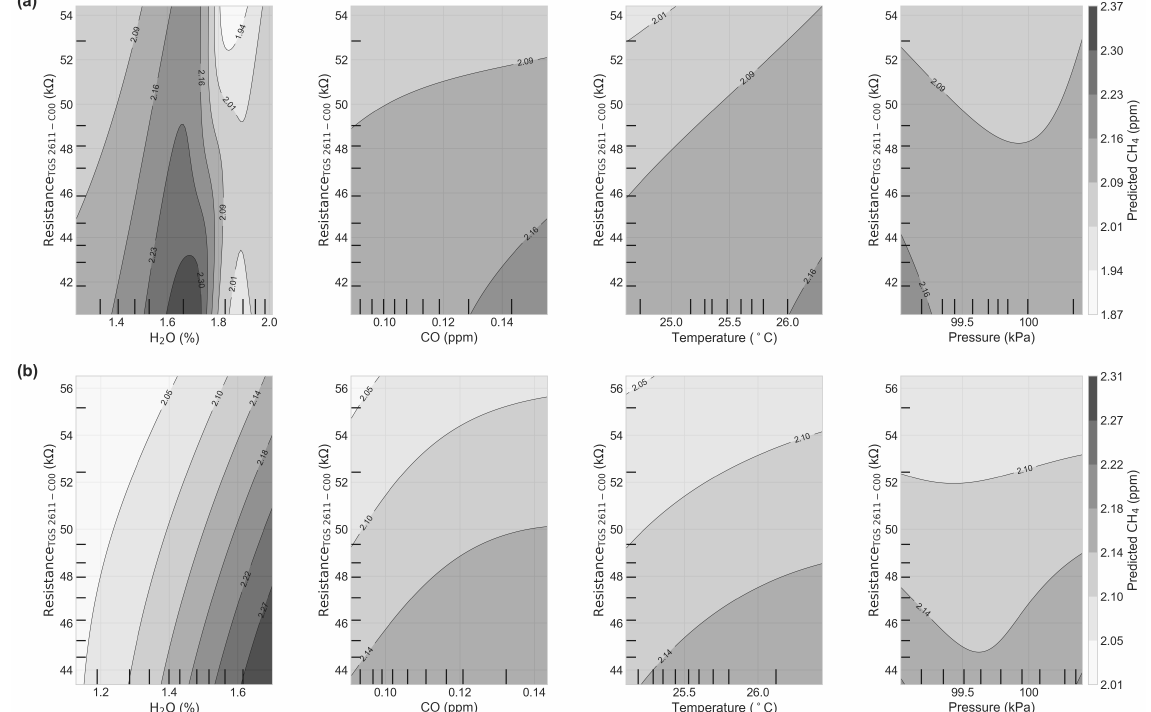
Figure 11. Bivariate partial dependence plot for the TGS 2611-C00 sensor versus H 2 O mole fraction, CO, air temperature and pressure. ( a ) Partial Dependence Plot (PDP) for the model trained in the best case scenario and ( b ) Partial Dependence Plot (PDP) for the worst case scenario. Ticks on the x and y axes of the figures are the deciles of the input